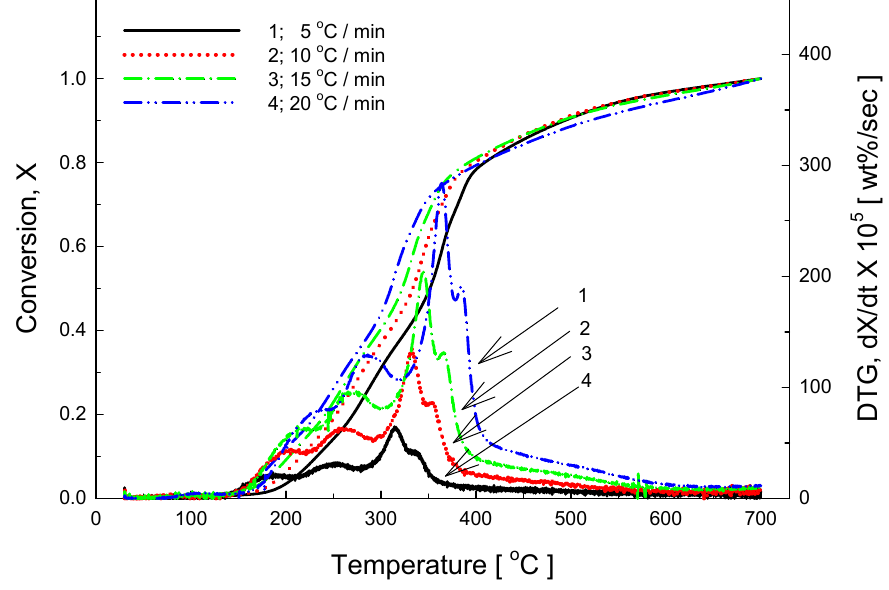
Figure 4. TG and DTG curves of vegetable pyrolysis at heating rates of 5, 10, 15, and 20 °C/min.